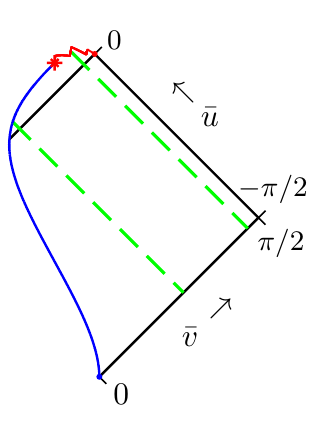
Figure 7 . Solution \ (cid:0) " in eq. (3.22) with four s = 1 = 2 poles and parameters (cid:21)a 1 = (cid:0) 0 : 1, (cid:21)b 1 = 1, (cid:21)a 2 = 0 : 2, (cid:21)b 2 = 10, and e (cid:0) 2 (cid:30) 0 = 1. The two peaks of the incoming matter (cid:13)ux are marked by the dashed lines. For this choice of parameters, the second peak forms the black